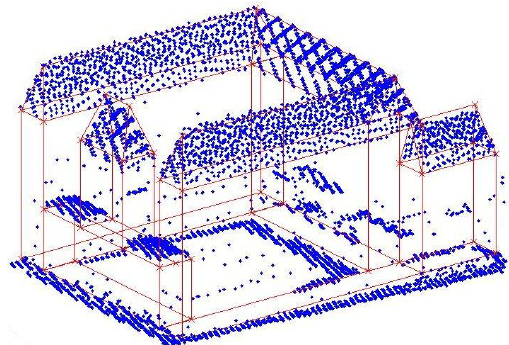
Figure 5. Reconstructed 3D building model